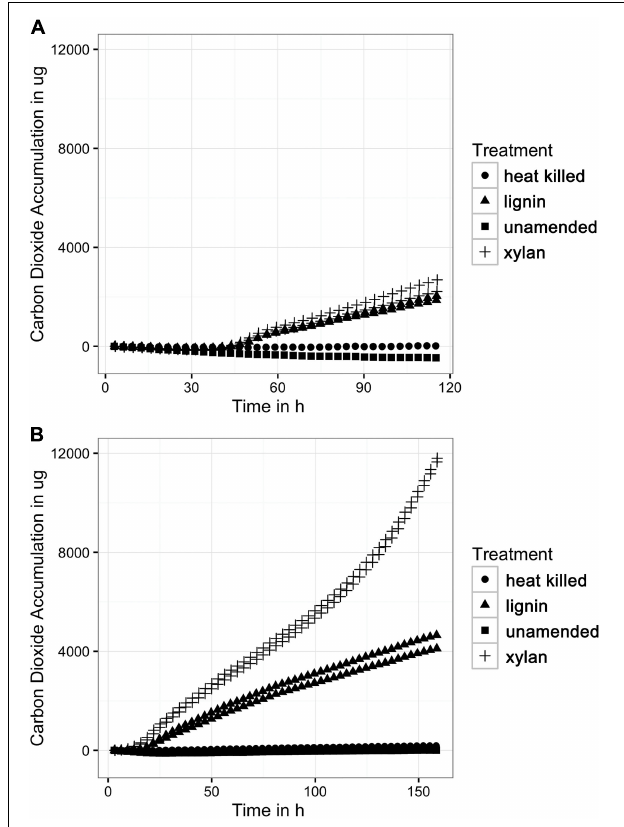
FIGURE 1 | (A) Carbon dioxide production from the first incubation of xylan and lignin. The MicroOxyMax respirometer monitored carbon dioxide accumulation in the head space of the three different treatments: the xylan-amended ( n = 2), lignin-amended ( n = 2), unamended control ( n = 1), and abiotic control ( n = 1). (B) Carbon dioxide production from the second xylan and lignin incubation. The first xylan and lignin incubation was transferred to fresh media and substrate for a second incubation, which was also monitored for carbon dioxide